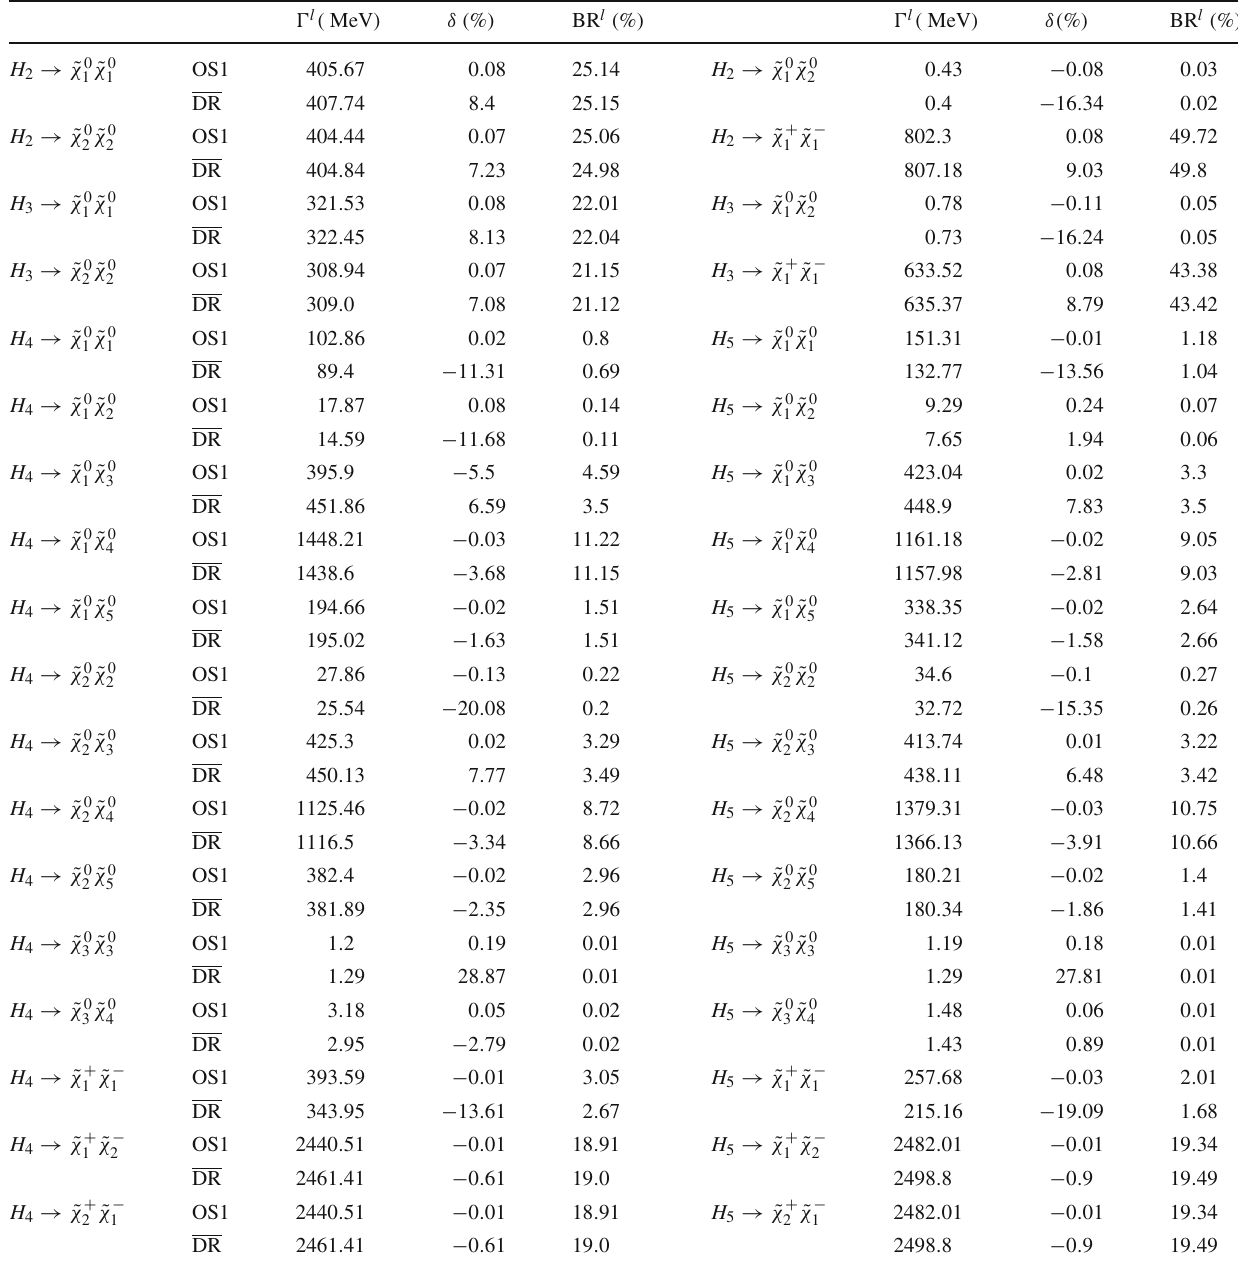
Table 4 Scenario 1: Loop-corrected decay widths (cid:19) l , relative loop bosons in the OS1 and DR renormalization schemes. The results in the corrections δ and loop-corrected branching ratios BR l of all kinemati- OS2 scheme are nearly the same as in OS1 scheme cally allowed decays into chargino and neutralino pairs of heavy Higgs (cid:19) l ( MeV ) δ (%) BR l (%) (cid:19) l ( MeV